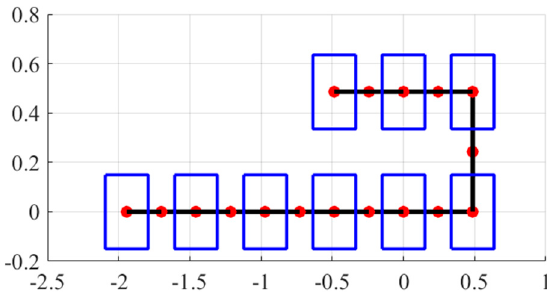
Figure 15. Final configuration of SMSRS in case 1.